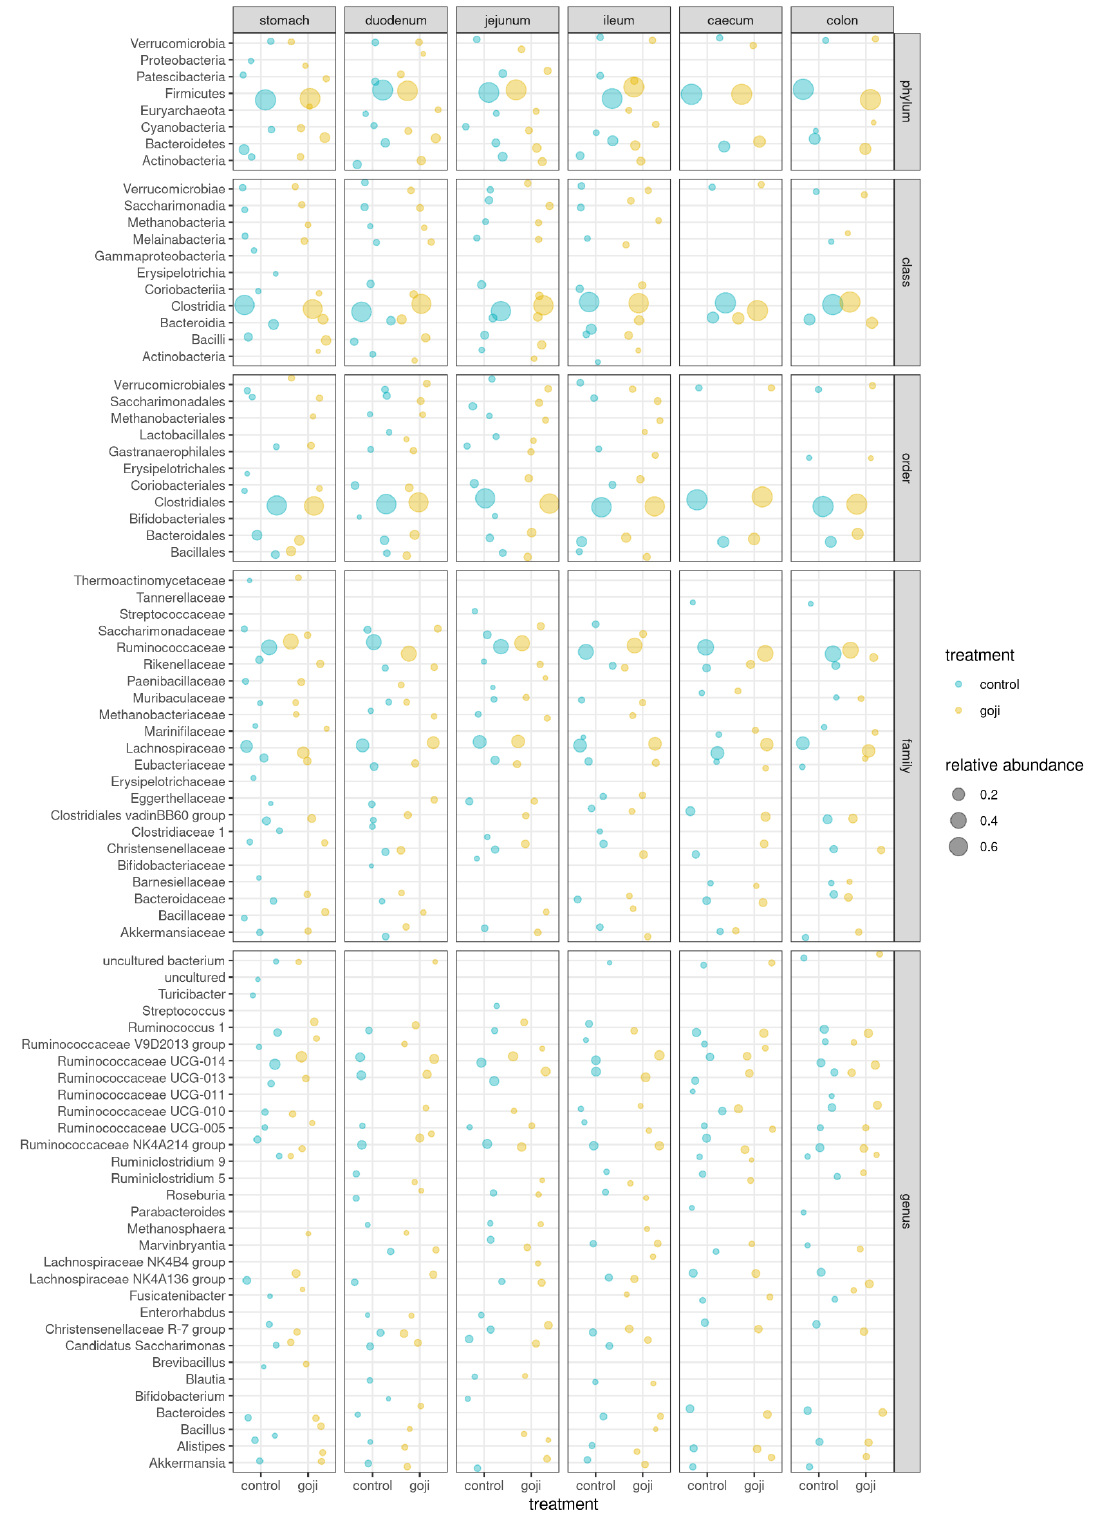
Figure 2. Bubble chart of relative abundances of all taxa ( ≥ 1%) in the microbiota of the digestive tract of rabbits, grouped by taxonomic level. Control (blue = 14 rabbits) and Goji (yellow = 13 rabbits) experimental groups. The size of the bubble is proportional to the relative abundance, with 0.2, 0.4 and 0.6 hallmarks, as shown in the legend.